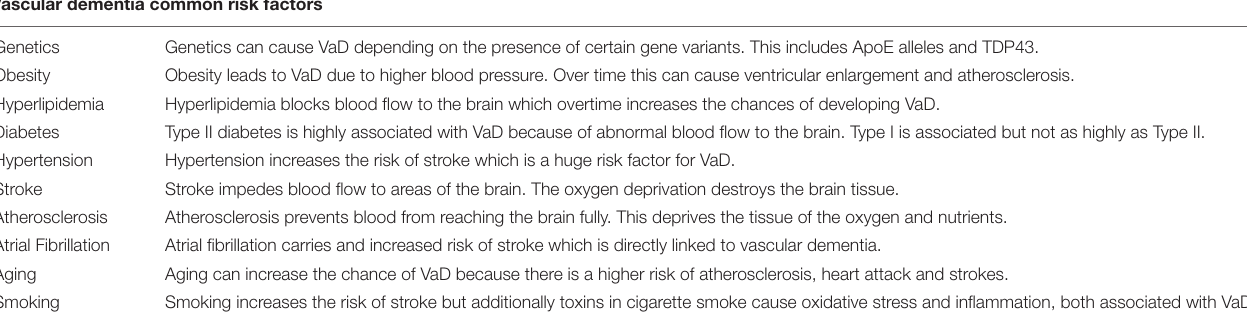
TABLE 2 | General risk factors of VaD. Vascular dementia common risk factors